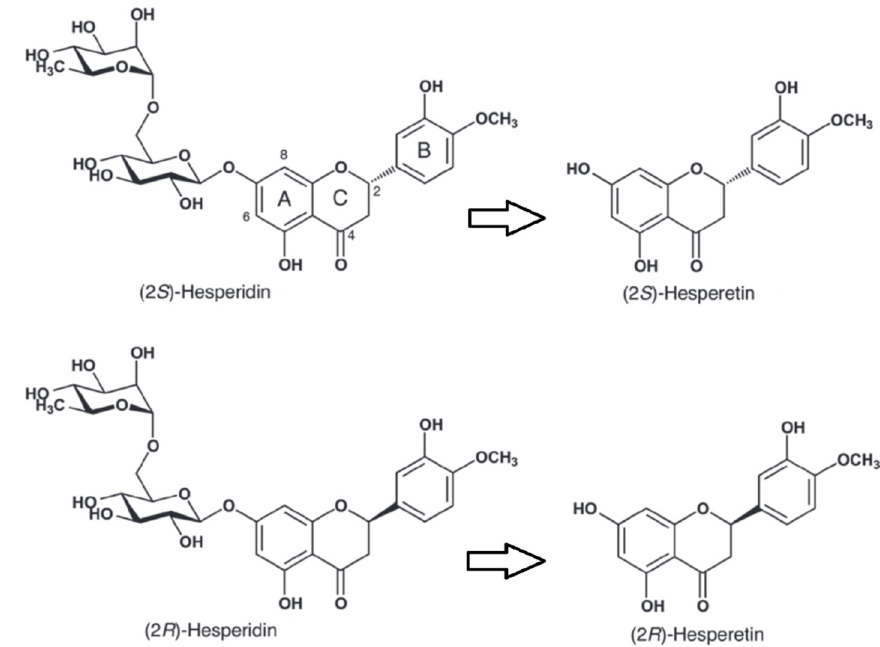
Figure 1. Structure of hesperidin enantiomers S and R and their metabolites hesperetin, produced by the intestinal microbiota. Modified from Li et al. [10] .